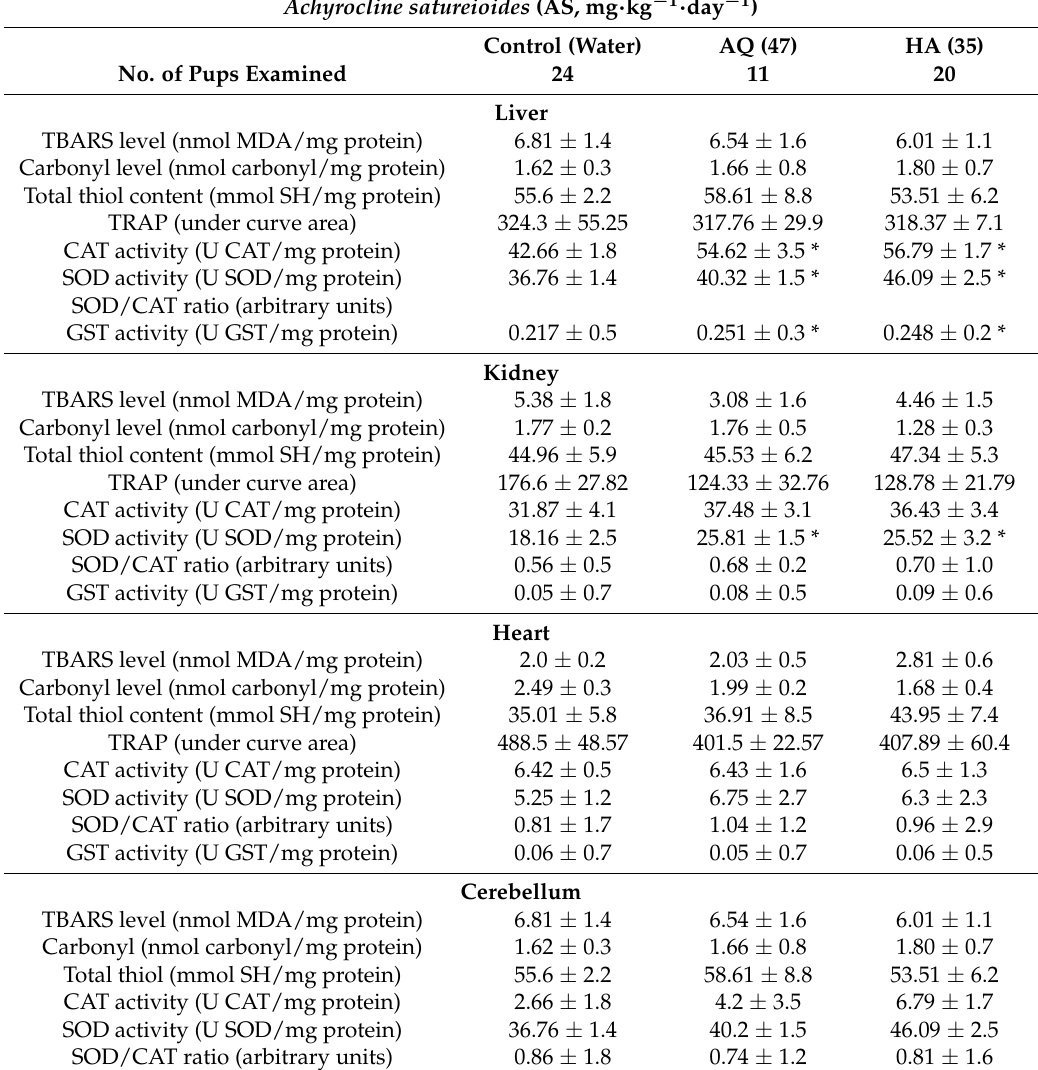
Table 4. Biochemical data of the tissues of the